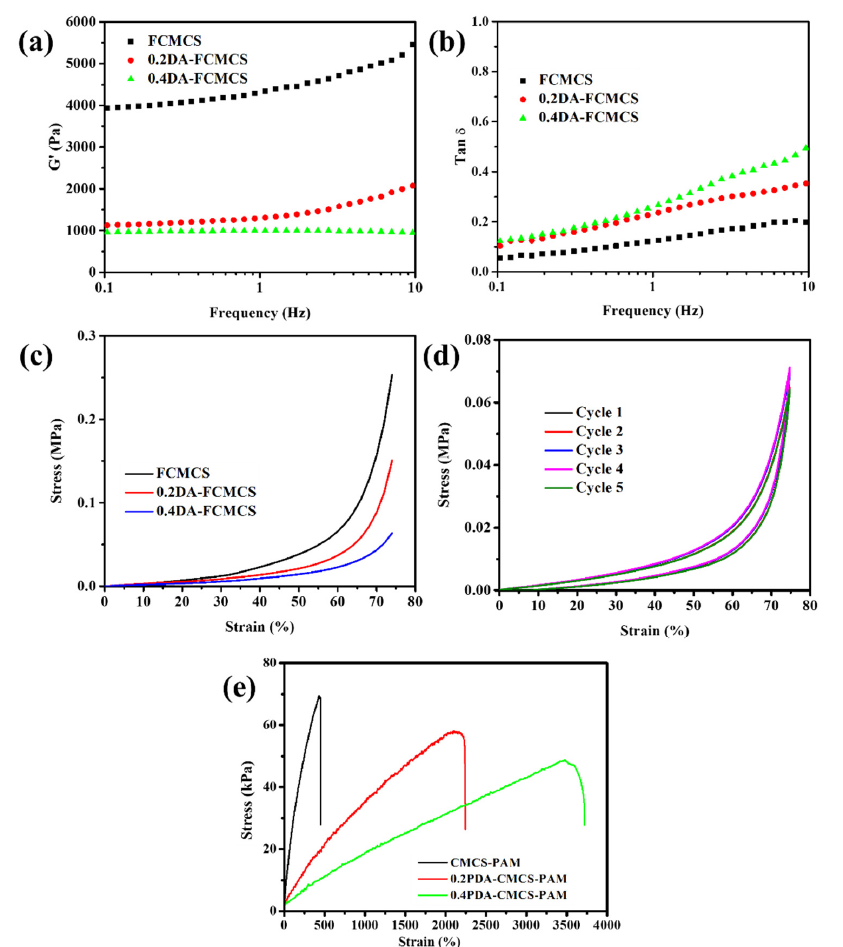
Figure 3. ( a ) Rheology storage modulus (G ′ ), ( b ) loss factor (Tan δ ) of hydrogels, ( c ) compressive properties of hydrogels, ( d ) cyclic compressive property of 0.4DA-FCMCS hydrogel, and ( e ) tensile stress–strain curve of hydrogels.